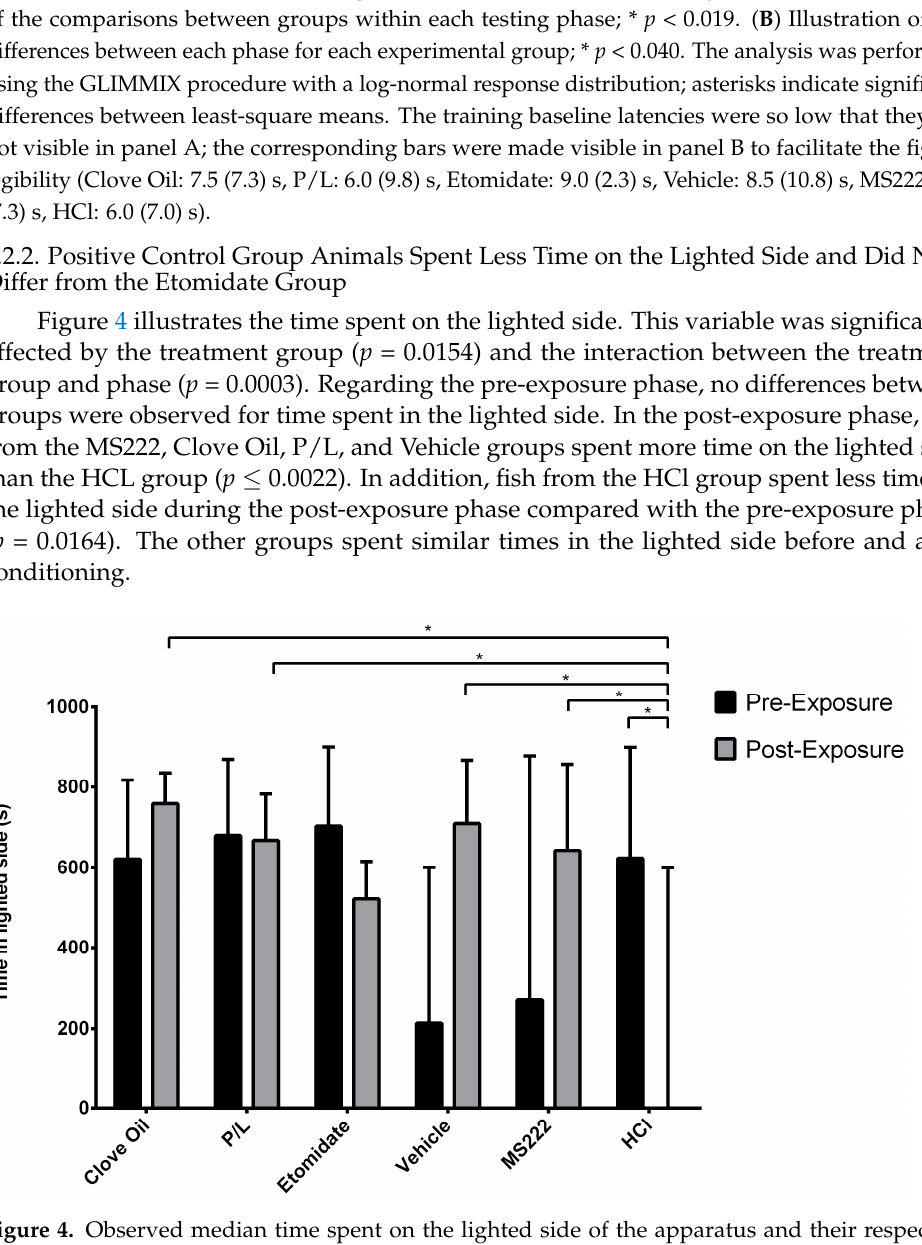
Figure 4. Observed median time spent on the lighted side of the apparatus and their respective interquartile ranges in each treatment group during the pre ‐ exposure and post ‐ exposure phases. Clove Oil group: animals subjected to 45 mg/L of clove oil (n = 12); P/L group: animals subjected to 5 mg/L of propofol combined with 150 mg/L of lidocaine (n = 10); Etomidate group: animals subjected to 2 mg/L of etomidate (n = 9); Vehicle group: animals subjected to 5 mg/L of intralipid (n = 12); MS222 group: animals subjected to 150 mg/L of MS222 (n = 12); HCl group: animals subjected to pH 3 water with hydrochloride acid (n = 11). * p ≤ 0.016 using the MIXED procedure for testing the square ‐ root ‐ transformed lighted ‐ side index (time spent on the lighted side/total time spent in both sides); asterisks indicate significant differences between least ‐ square means of groups and phases.